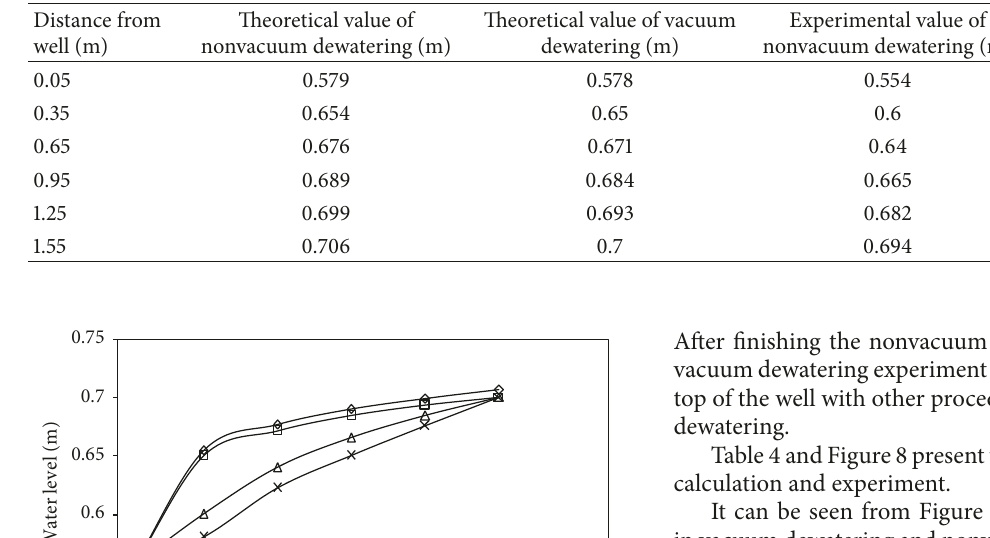
Table 4: Water level in constant waterhead condition.